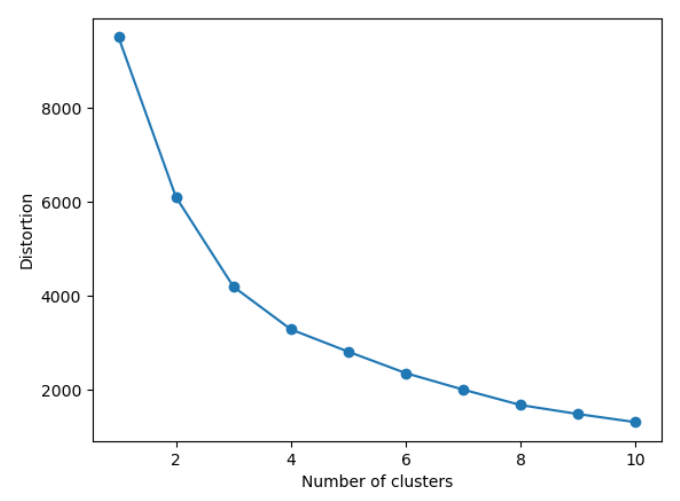
Figure 4. Elbow diagram. x-axis = Number of clusters; y-axis = Distortion (sum of square errors) of data points in the clusters. The clustering was performed with KMeans over eudaimonic and hedonic variables.